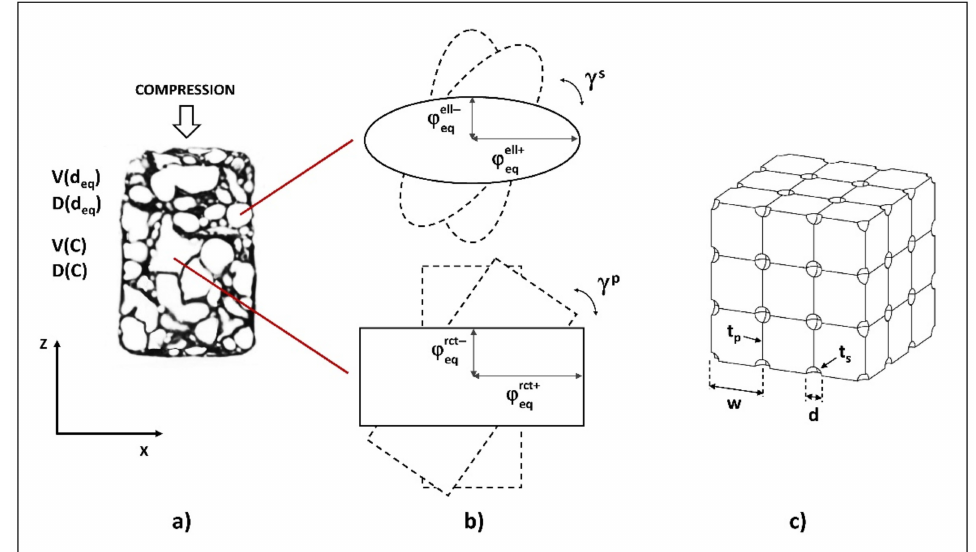
Figure 5. Cellular structure and parameters transformation: ( a ) Real section with local morphological parameters; ( b ) Intermediate model; ( c ) Reference model with global